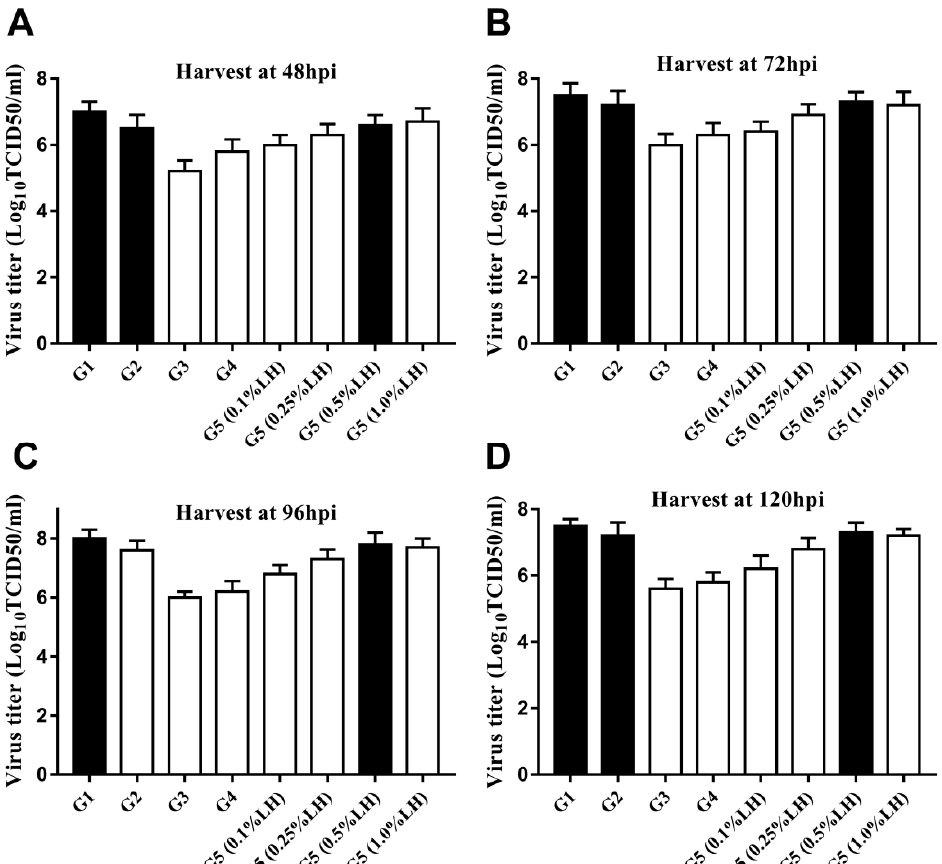
Figure 2. CVA16 virus production using different culture strategies and medium supplements. The virus titer of the supernatant was collected after growth using five different medium addition strategies: ( A ) 48 hpi, ( B ) 72 hpi, ( C ) 96 hpi, and ( D ) 120 hpi (group G1–G5). CVA16, Coxsackie virus A16; hpi, hours post-infection.